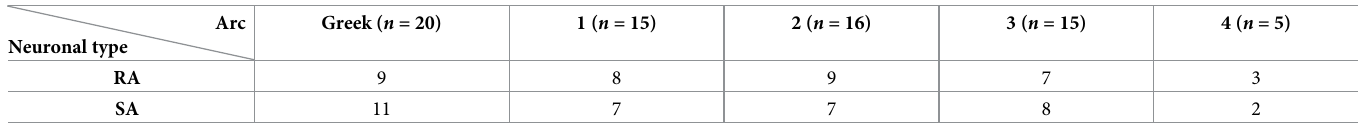
Table 1. Distribution of neuronal types across all